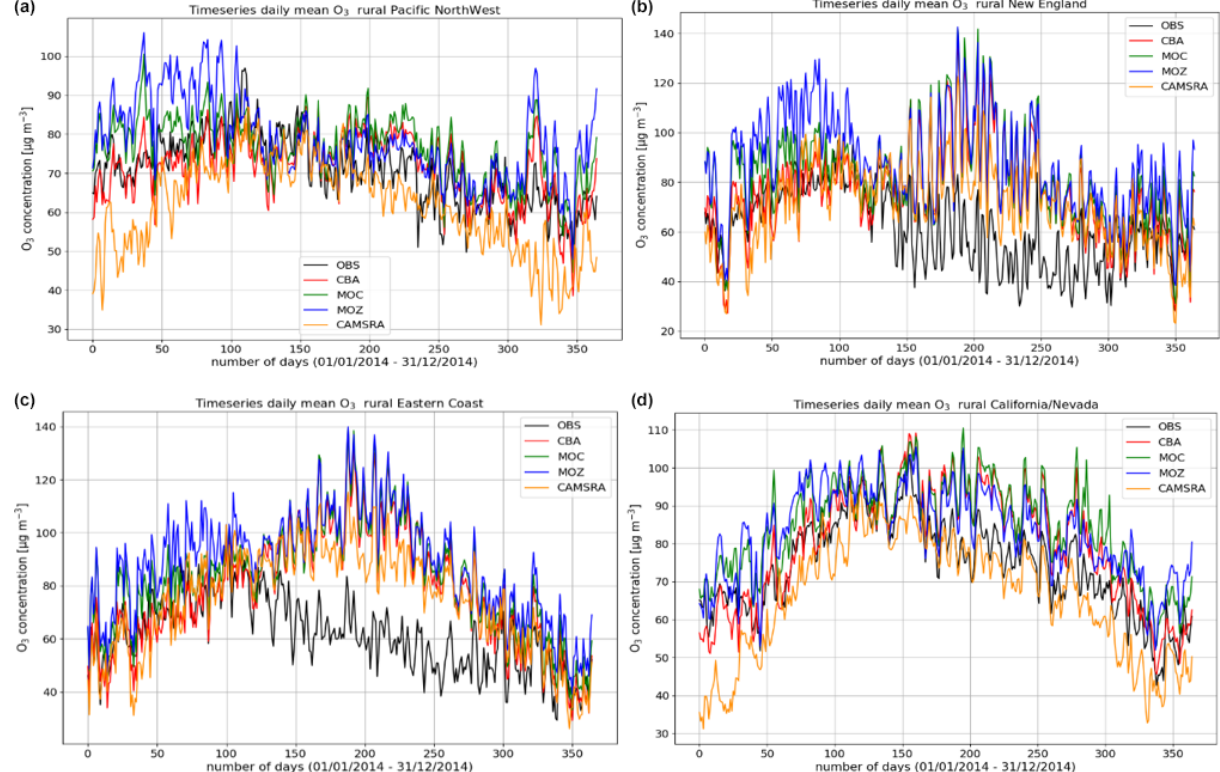
Figure 5. Comparisons of the daily mean variability surface O 3 for 2014 against regional composites assembled from measurement sites for rural locations contributing to the AirNow network. Regions shown ( a to d ) are the Pacific Northwest, New England, eastern US, and California and